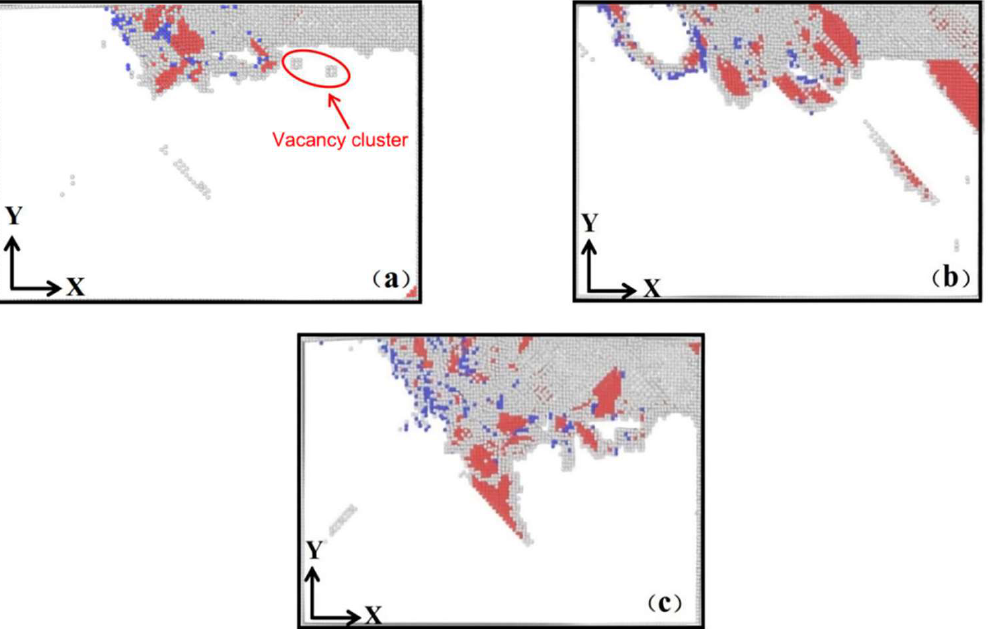
Figure 7. Distribution of subsurface defects at different cutting depths (without water medium) (( a ) cutting depth is 2 nm ( b ) cutting depth is 3 nm ( c ) cutting depth is 4 nm). The red is HCP atoms, the blue is BCC atoms, and the cutting depths of a, b and c are